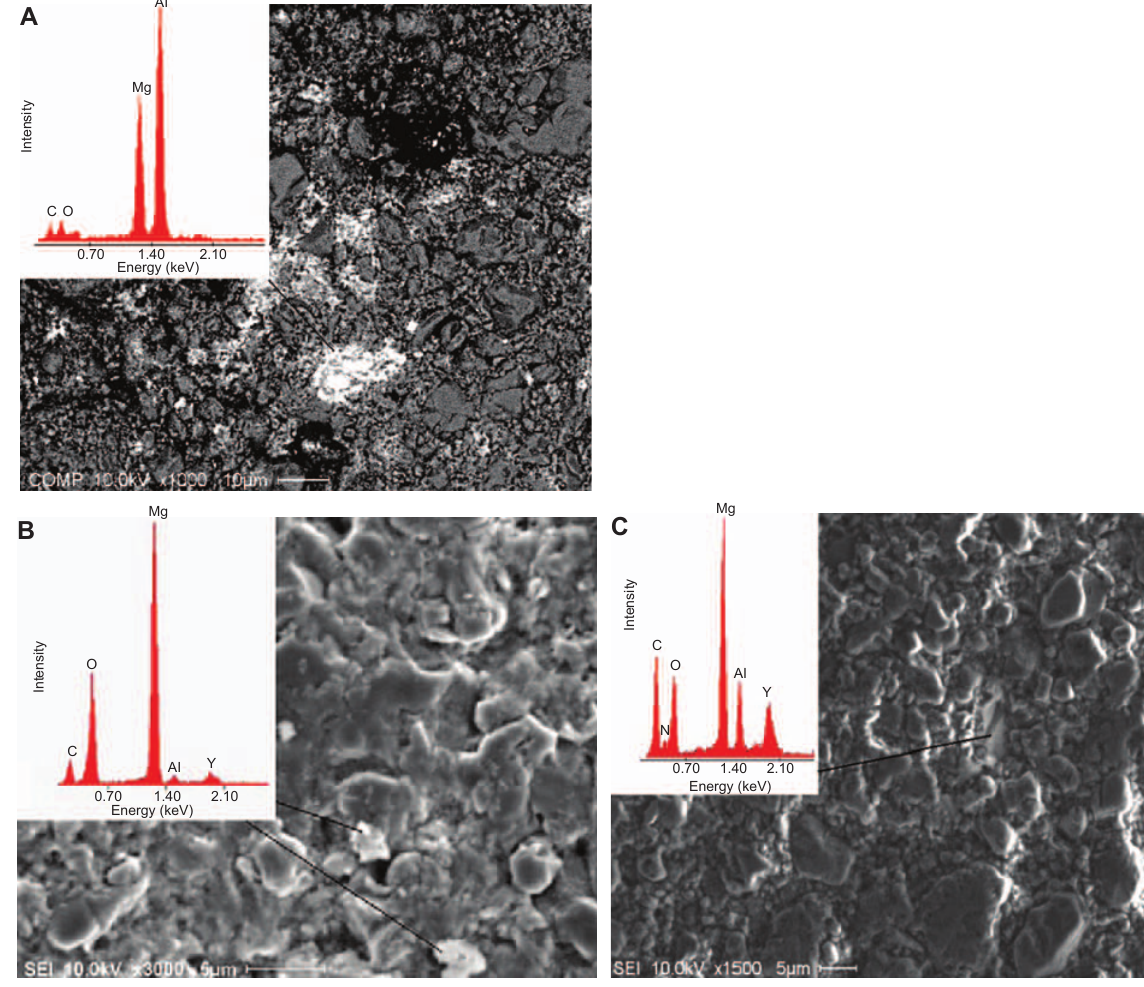
Figure 3 SEM micrographs of samples infi ltrated at: a) 650 ° C for 135 min, b) 800 ° C for 90 min, c) 950 ° C for 135